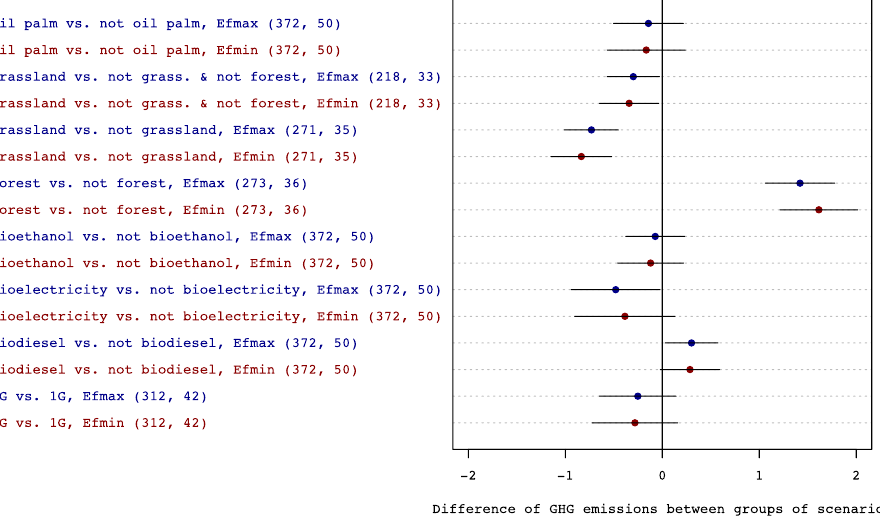
Figure 2. Estimated differences in effect-size R between groups of bioenergy scenarios. Either the minimum (Efmin) or maximum (Efmax) reference value for the GHG emissions of the fossil counterfactuals were used. The horizontal bars depict 95% confidence intervals. The number of scenarios and the number of articles used in each group are given in brackets. Key to groups: ‘1G’ and ‘2G’: 1 st and 2 nd generation biofuels; ‘Forest’: forest as initial land-use; ‘Grassland’: grassland (including degraded pastures) as initial land-use; ‘Oil Palm’: biodiesel from palm oil; ‘Biodiesel’: production of biodiesel; ‘Bioelectricity’: production of bioelectricity; ‘Bioethanol’: production of